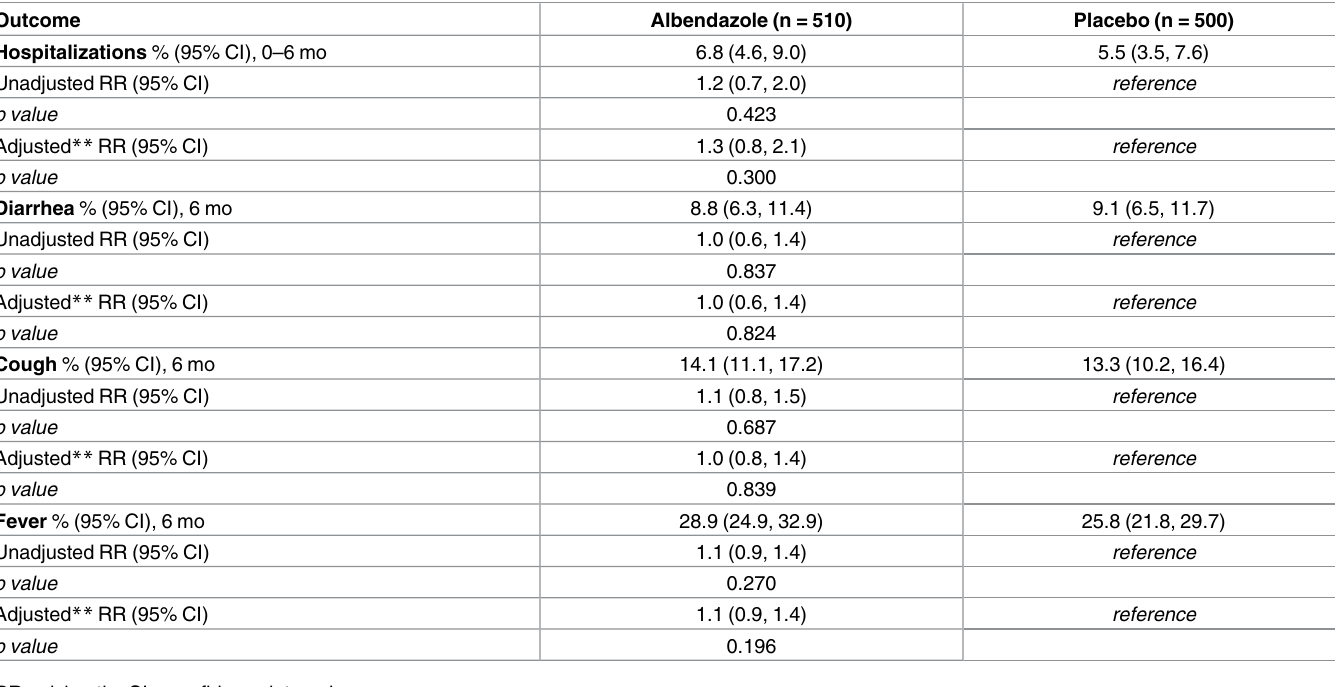
Table 6. Effect of maternal postpartum deworming on infant morbidity indicators at 6 months of age (N = 1010 * ),Iquitos, Peru (February 2014 – February 2015).